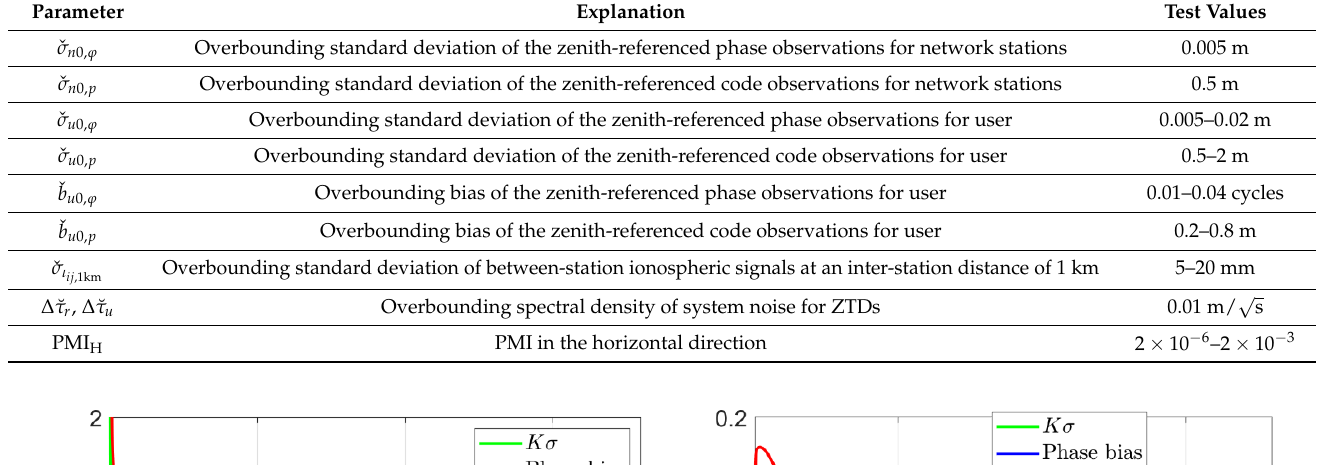
Table 6. Overbounding parameters tested for integrity purpose.